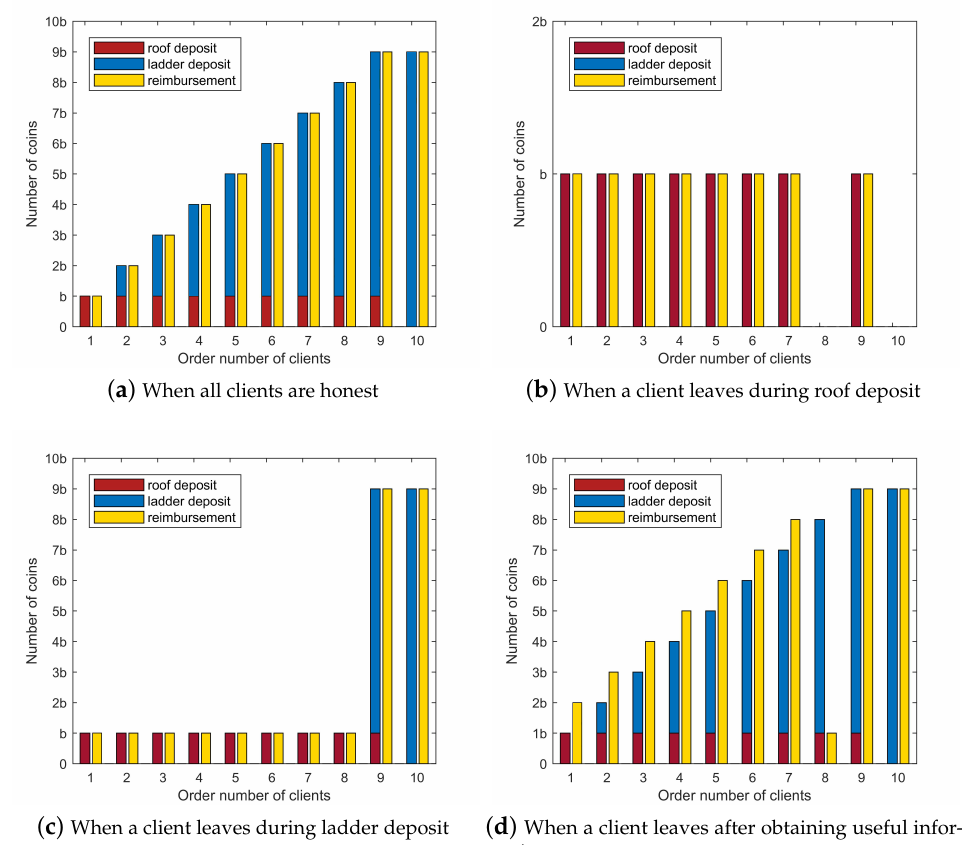
Figure 9. The circulation of digital currencies when there are 10 clients participating in